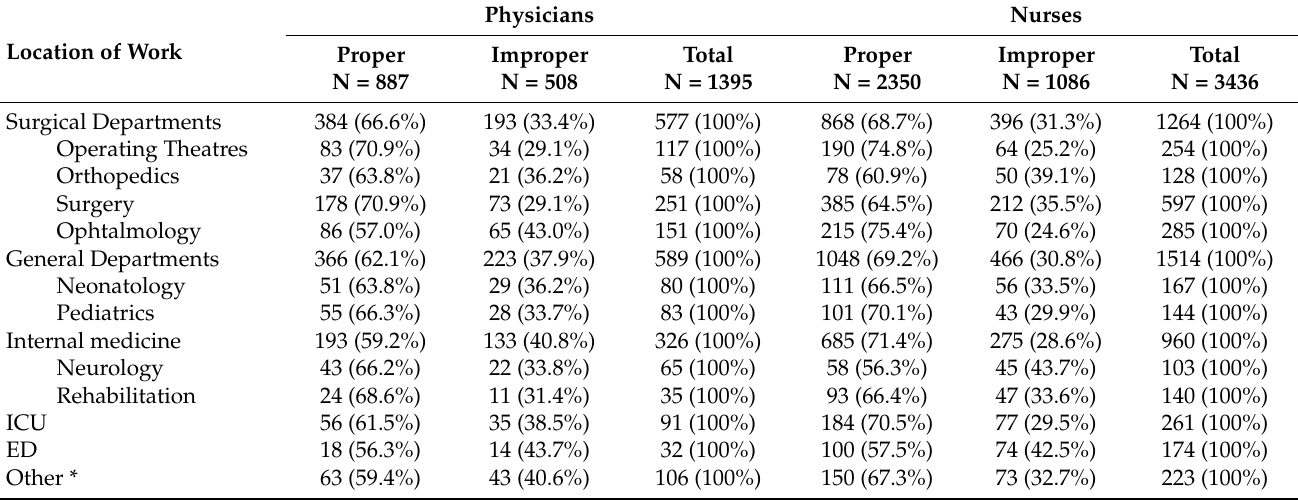
Table 2. Assessment of hand disinfection by physicians and nurses employed in hospital